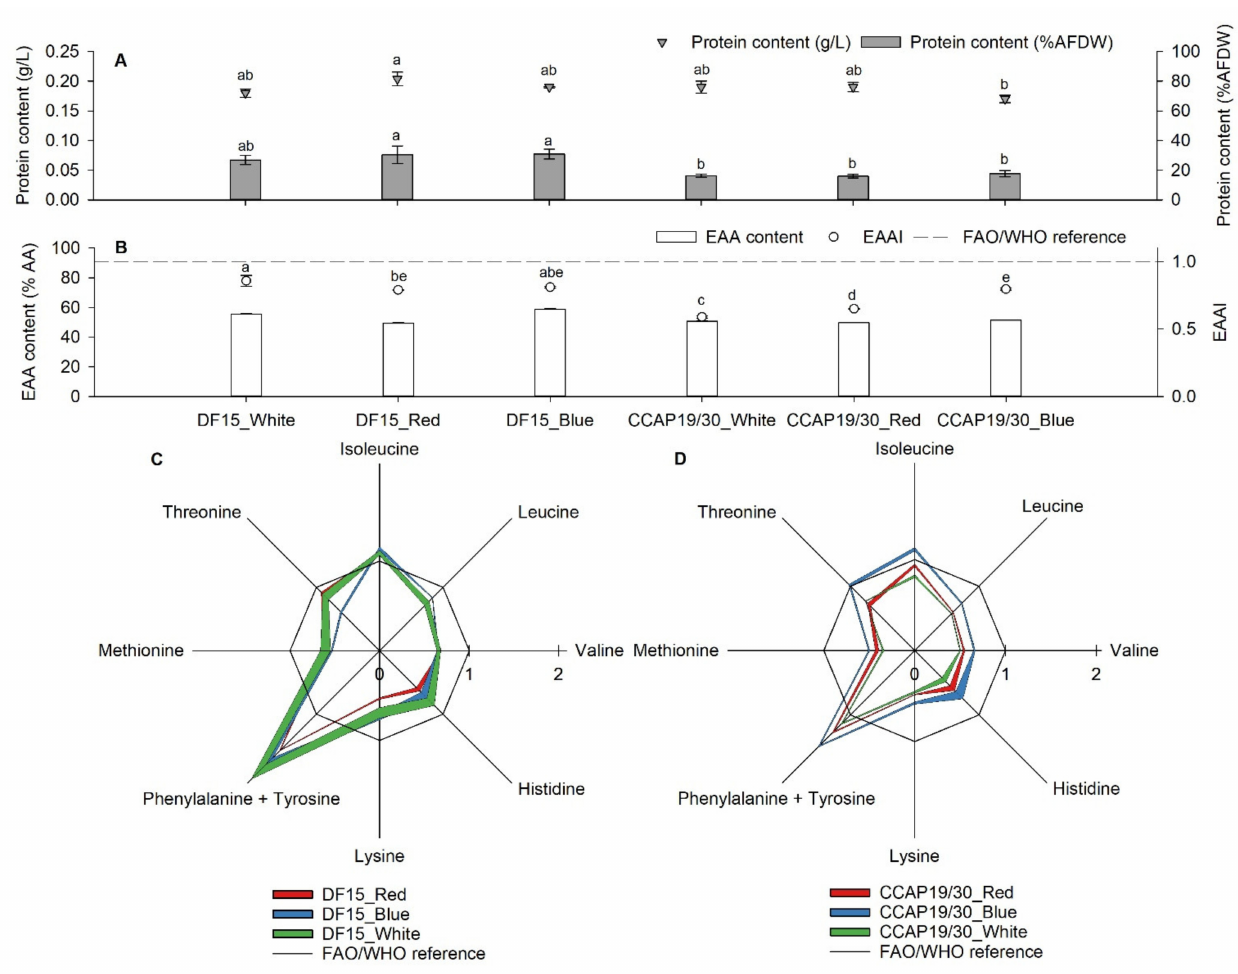
Figure 2. Protein content ( A ), EAA content, EAAI ( B ) and EAA profile of D. salina DF15 ( C ) and D. salina CCAP19/30 ( D ) at the end of the experiment. Cultivation was conducted at 25 ◦ C, pH 7.5 and 100 rpm mixing using white, red and blue light at 200 µ mol photons m − 2 s − 1 . Data are expressed as the means ± standard deviation. The different letters indicate statistically different groups (significance level at p -value <